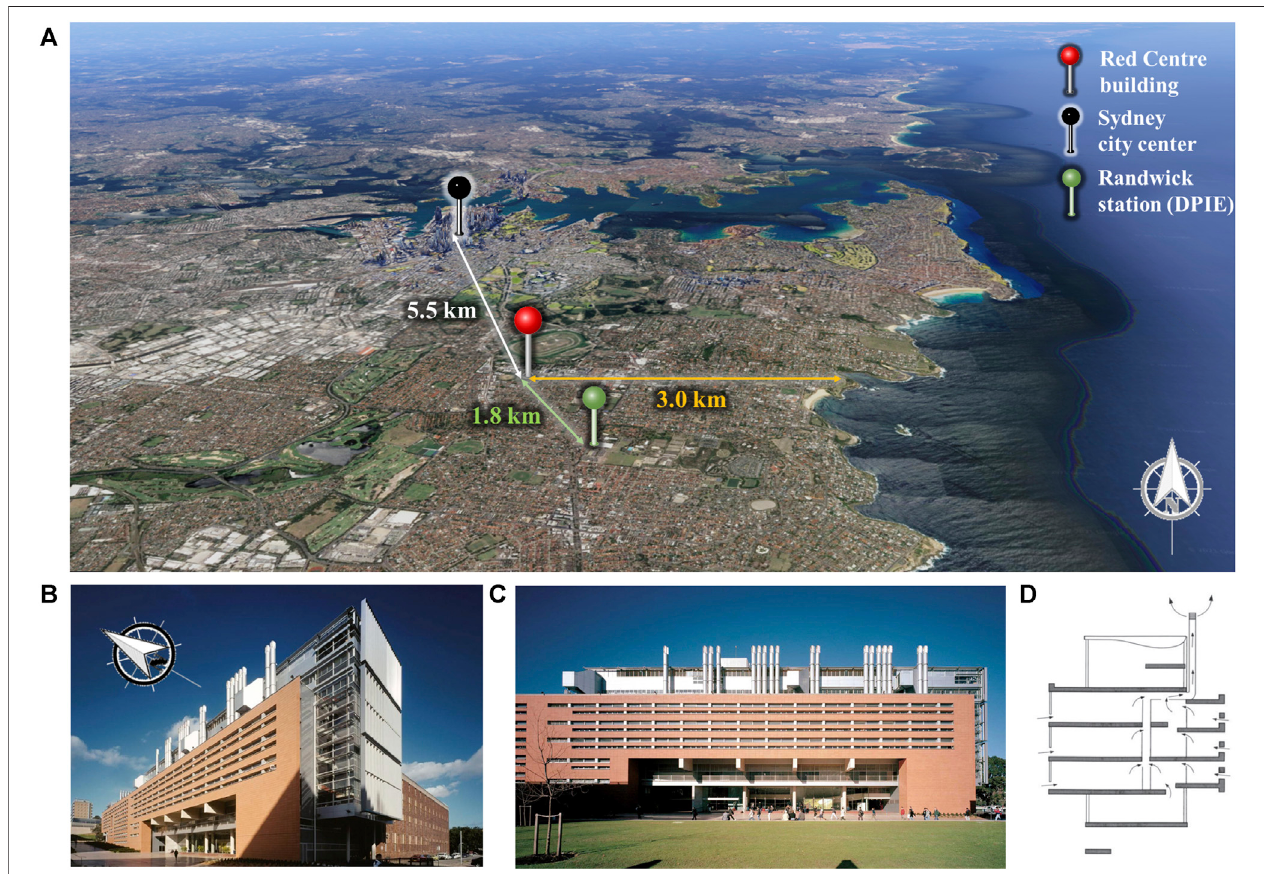
FIGURE 1 | The case study: (A) geolocalization of the University Campus and the Red Centre Building (red marker) with reference to Sydney ’ s center to the north- west,thecoastlinetotheeast and theoutdoordata referencestation (see SensorNetwork section); (B) North-West viewofthebuildingincluding the vertical shading on the western facade; (C) frontal (north) view of the building where the terracotta tiles and the solar chimneys are implemented; (D) schematics of the ventilation strategy comprised of internal passages and discharge through the solar chimneys.